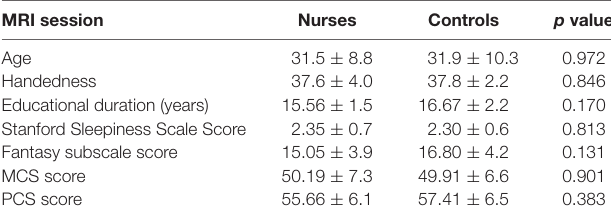
TABLE 2 | Comparative demographics of the participants in the MRI session.